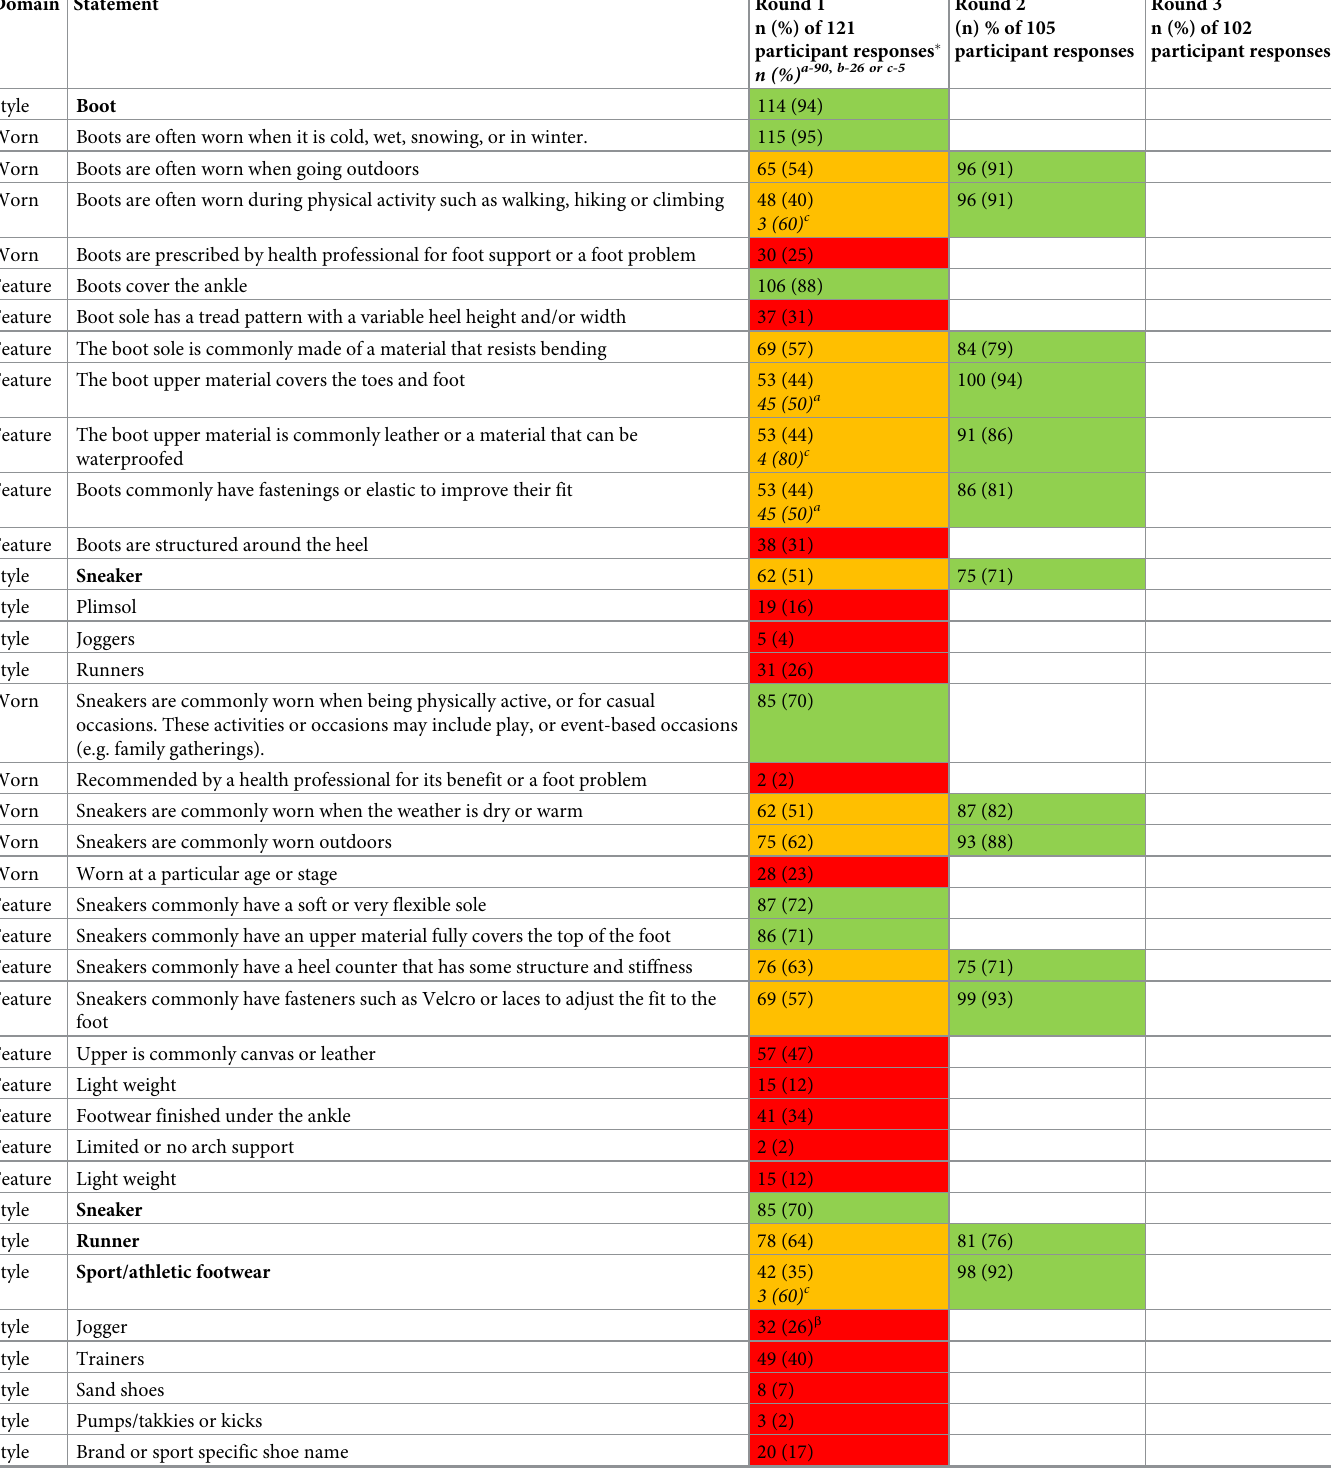
Table 3. Generated statements about young children’s footwear taxonomy and round in which the statements were